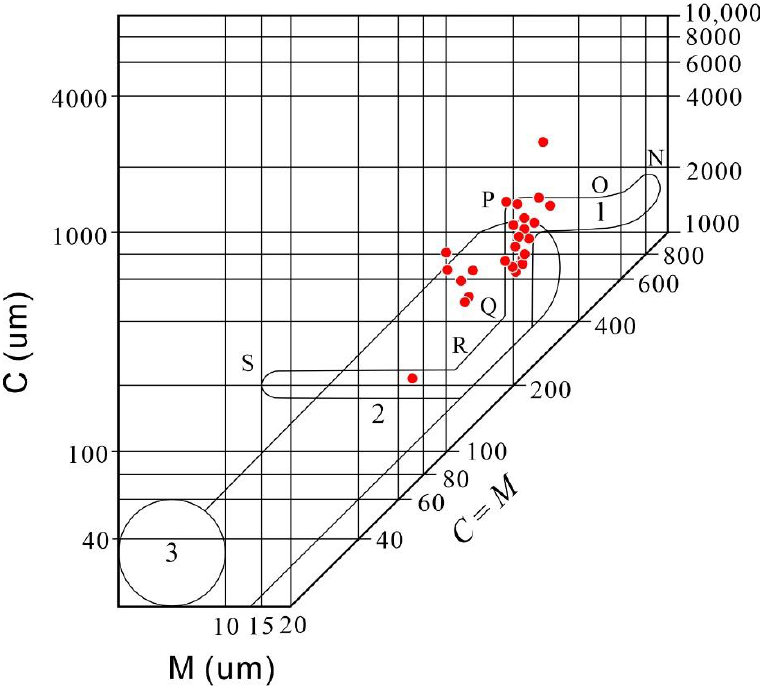
Figure 5. Particle size C ⁃ M diagram of the Jiucaiyuan Formation in the Beisantai Uplift.